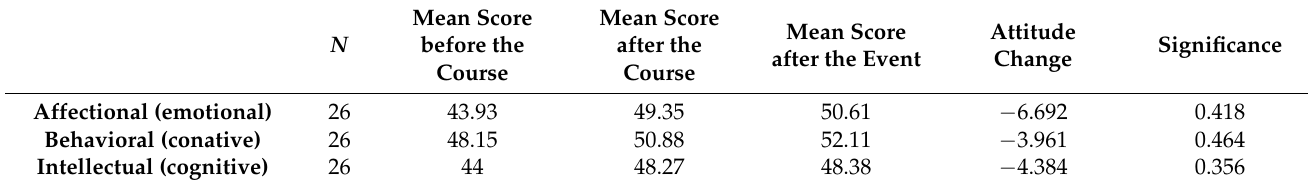
Table 1. Results of the CATCH survey and the distribution of